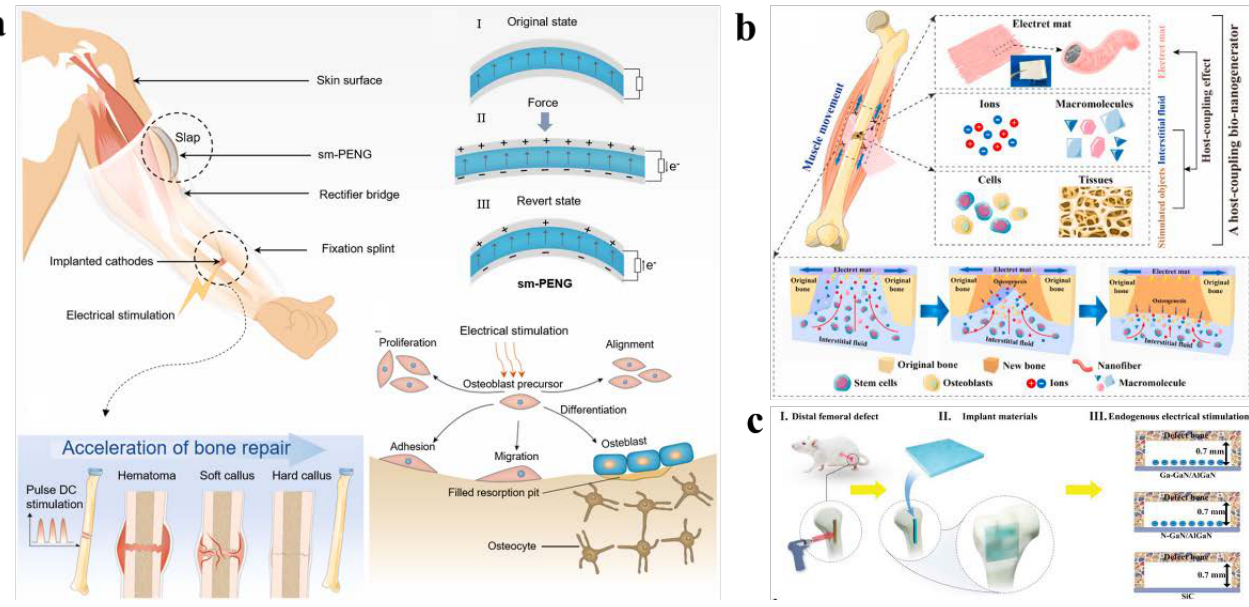
Figure 5. ( a ) Schematic diagram of self-powered electrical stimulation for bone repair [66] . ( b ) Schematic diagram of an electret-based HCBG implanted onto a bone injury in vivo [67] . ( c ) In vivo bone defect repairing ability of GaN/AlGaN films [68] .